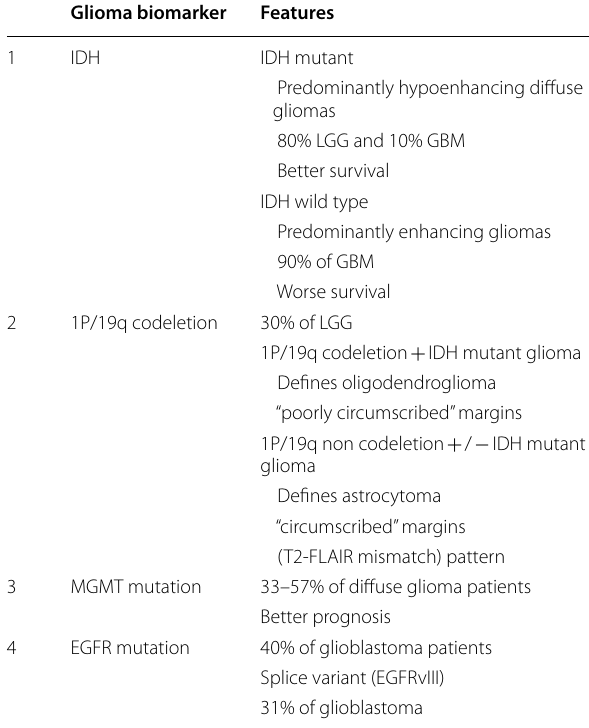
Table 2 Radiogenomic features of glioma